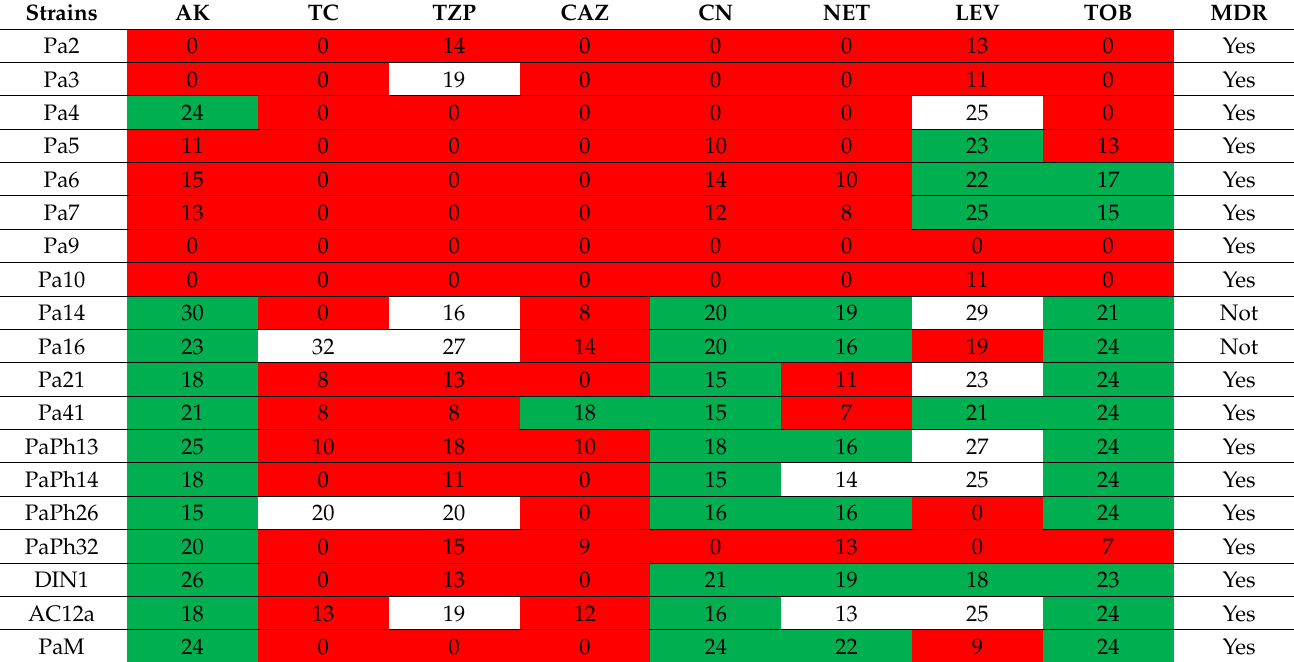
Table 2. Antibiotic susceptibility of 19 P. aeruginosa strains. The activity of amikacin (AK), ticarcillin (TC), piperacillin/tazobactam (TZP), ceftazidime (CAZ), colistin (CN), netilmicin (NET),